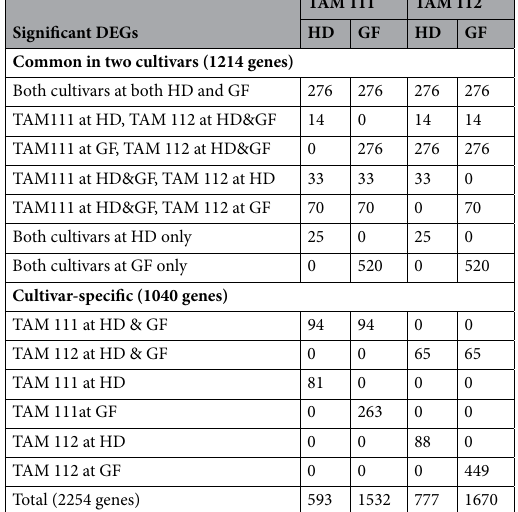
TAM 111 TAM 112 HD GF HD GF